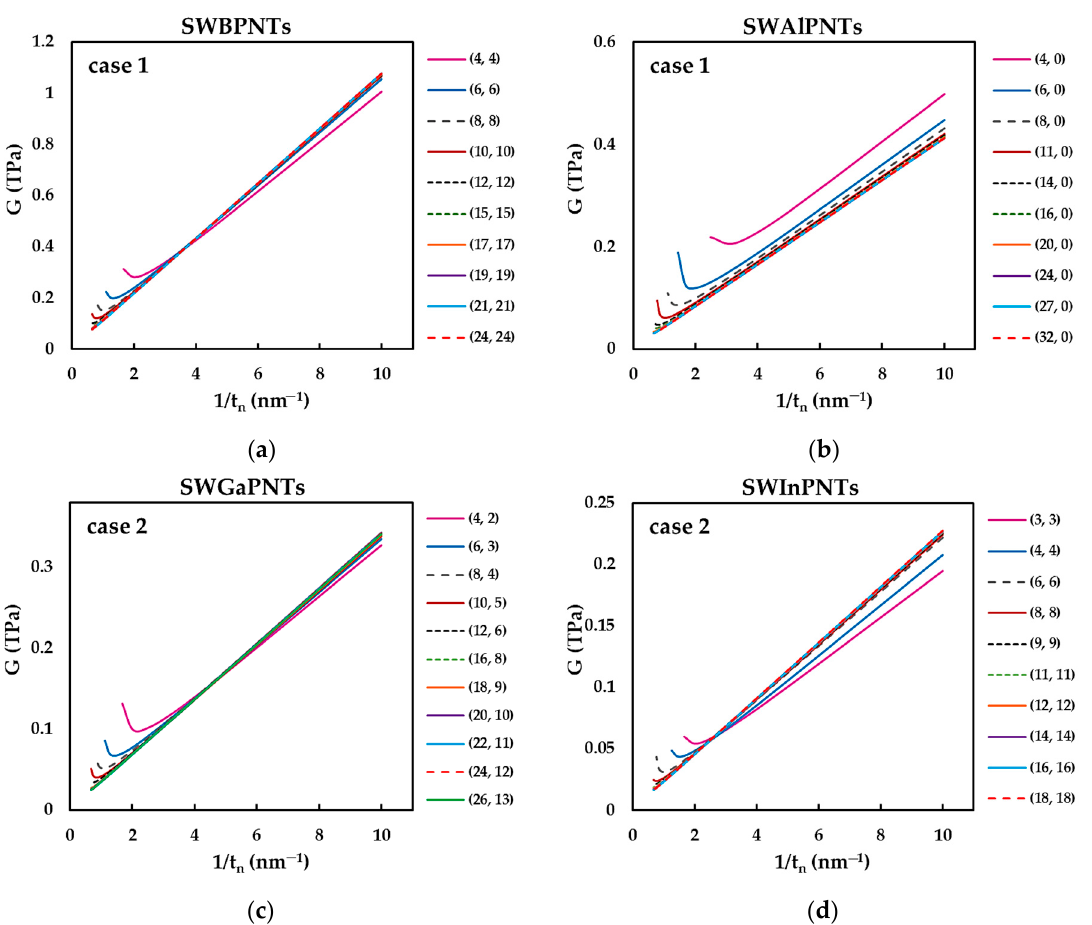
Figure 12. Evolution of the shear modulus, G, as a function of the inverse of the nanotube wall thickness, t n , for: ( a ) (n, n) SWBPNTs; ( b ) (n, 0) SWAlPNTs; ( c ) (n, m) SWGaPNTs; and ( d ) (n, n) SWInPNTs; ( a , b ) case 1, ( c , d ) case 2.